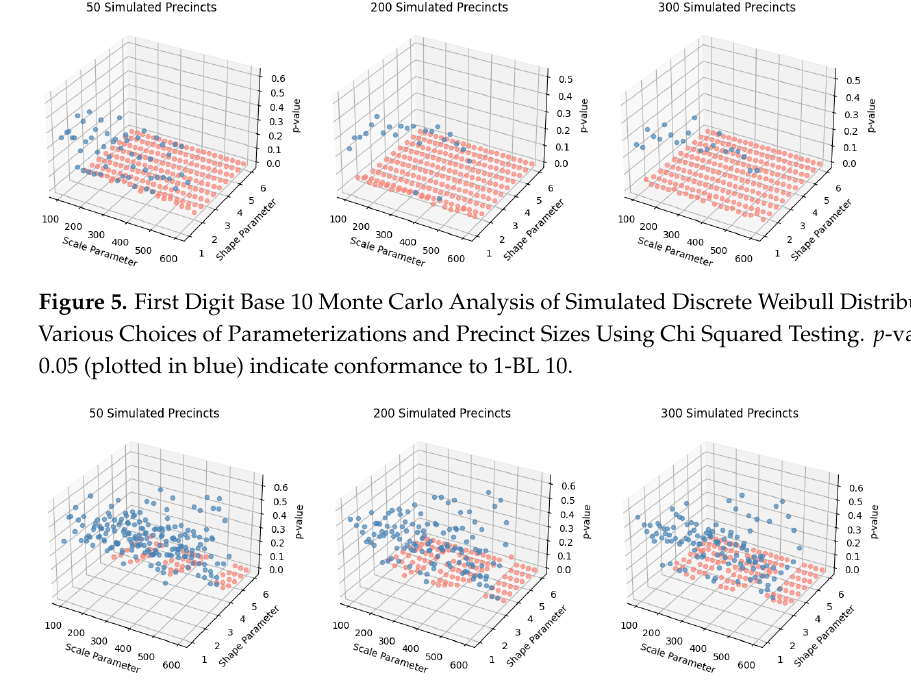
Figure 6. First Digit Base 3 Monte Carlo Analysis of Simulated Discrete Weibull Distributions with Various Choices of Parameterizations and Precinct Sizes Using Chi-Squared Testing. p -values above 0.05 (plotted in blue) indicate conformance to 1-BL